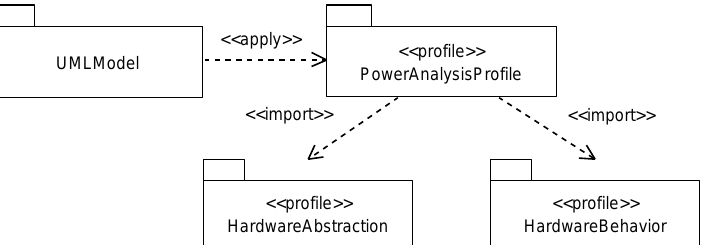
Figure 7. Overview and application of PAP in the proposed approach. (UML 2.5 package dia- gram notation).